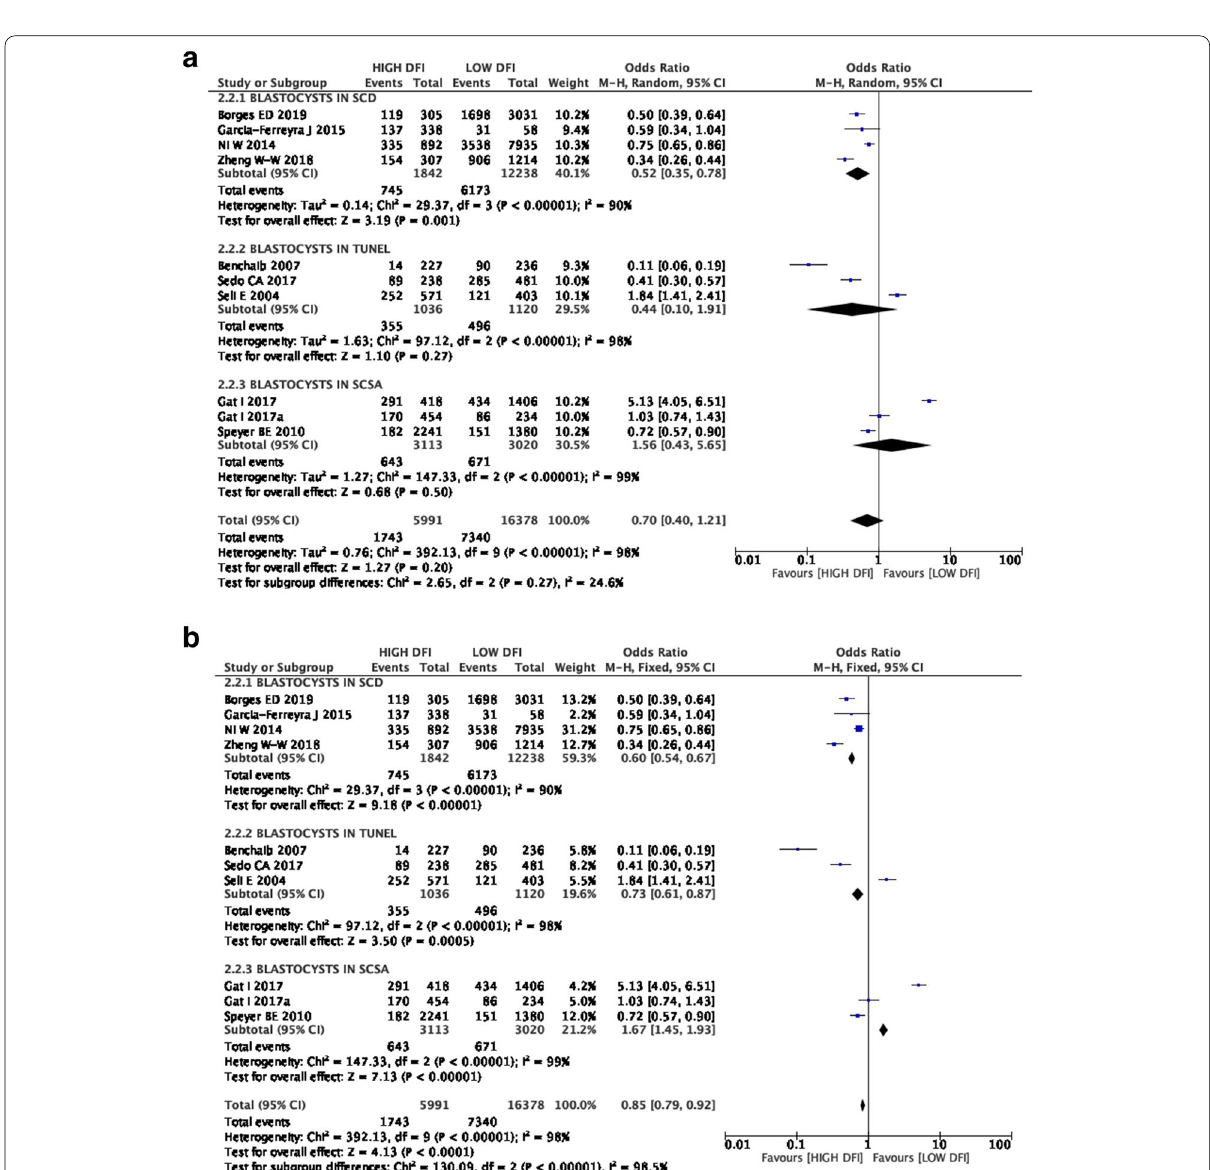
Fig. 3 a Comparison of blastulation rates in different sperm DNA assays (random). b Comparison of blastulation rates in different sperm DNA assays